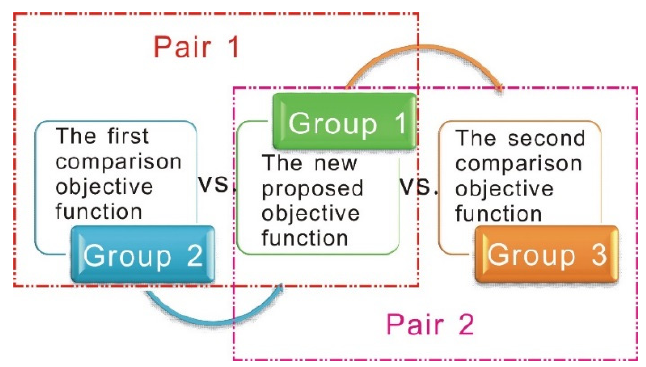
Figure 1. Groups and group pairs.